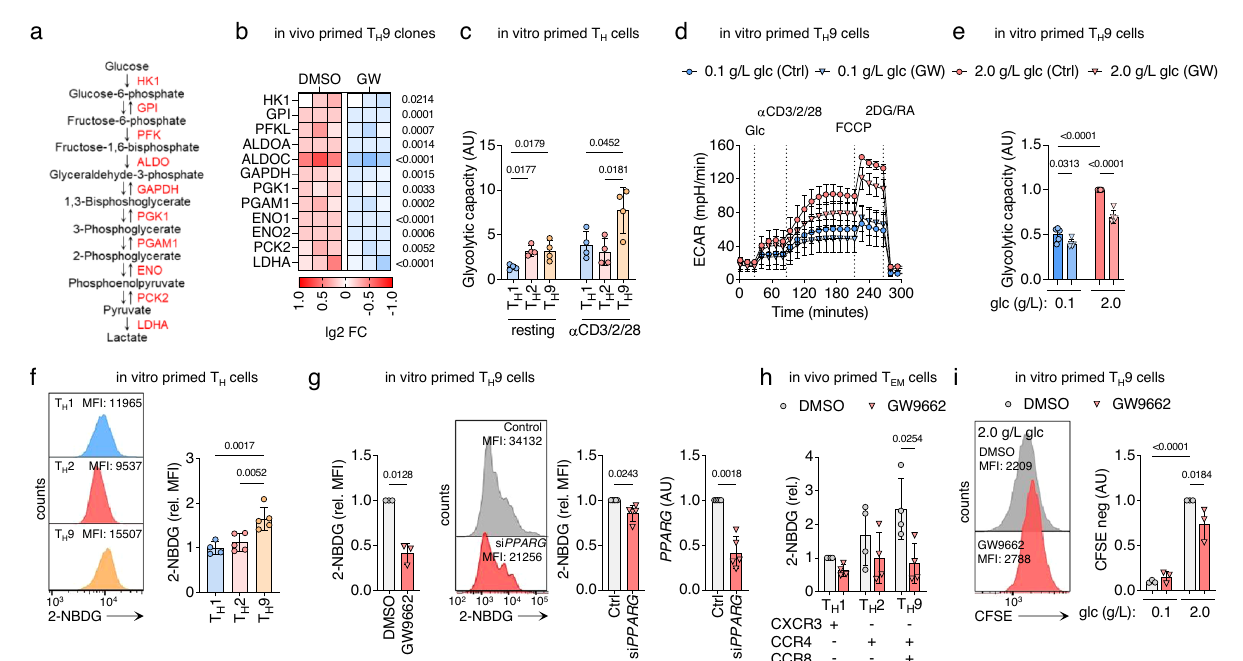
Fig.2|PPAR- γ mediatesthehighglycolyticactivityofT H 9cells.a Intermediates and enzymes (red) of aerobic glycolysis. b RNA-seq of T H 9 clones incubated in presenceofGW9662for48handactivatedby α CD3/CD2/CD28for12h. c Maximal glycolytic capacity of in vitro primed T H cells in the resting state and 24h after activation with α CD3/CD2/CD28. d ECAR measurements of in vitro primed T H 9 cells cultured in media with glucose of different levels and GW9662 for 48h and activated by injection of glucose and α CD3/CD2/CD28. e Maximal glycolytic capacityofinvitroprimedT H 9cellsfrom d . f GlucoseuptakebyinvitroprimedT H cells measured with fl uorescent 2-NBDG uptake by fl ow cytometry at day 7. g Glucose uptake by naive T H cells primed under T H 9 conditions for 7 days in presence of GW9662 or transfected with PPARG and control siRNA, respectively. Ef fi ciency of knockdown was determined by measuring PPARG levels after trans- fectionbyRT-qPCR(right). h GlucoseuptakeofinvivoprimedeffectormemoryT H cells (T EM ) sortedby fl owcytometryinto T H 1, T H 2,and T H 9 cells according to their